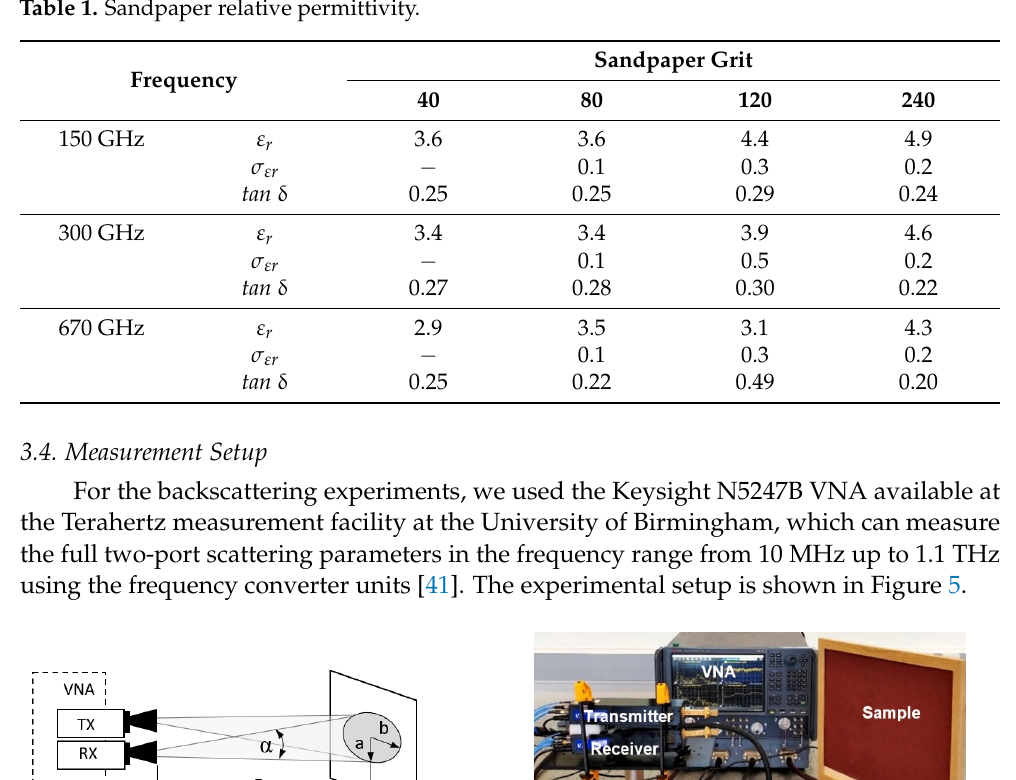
Table 1. Sandpaper relative permittivity.